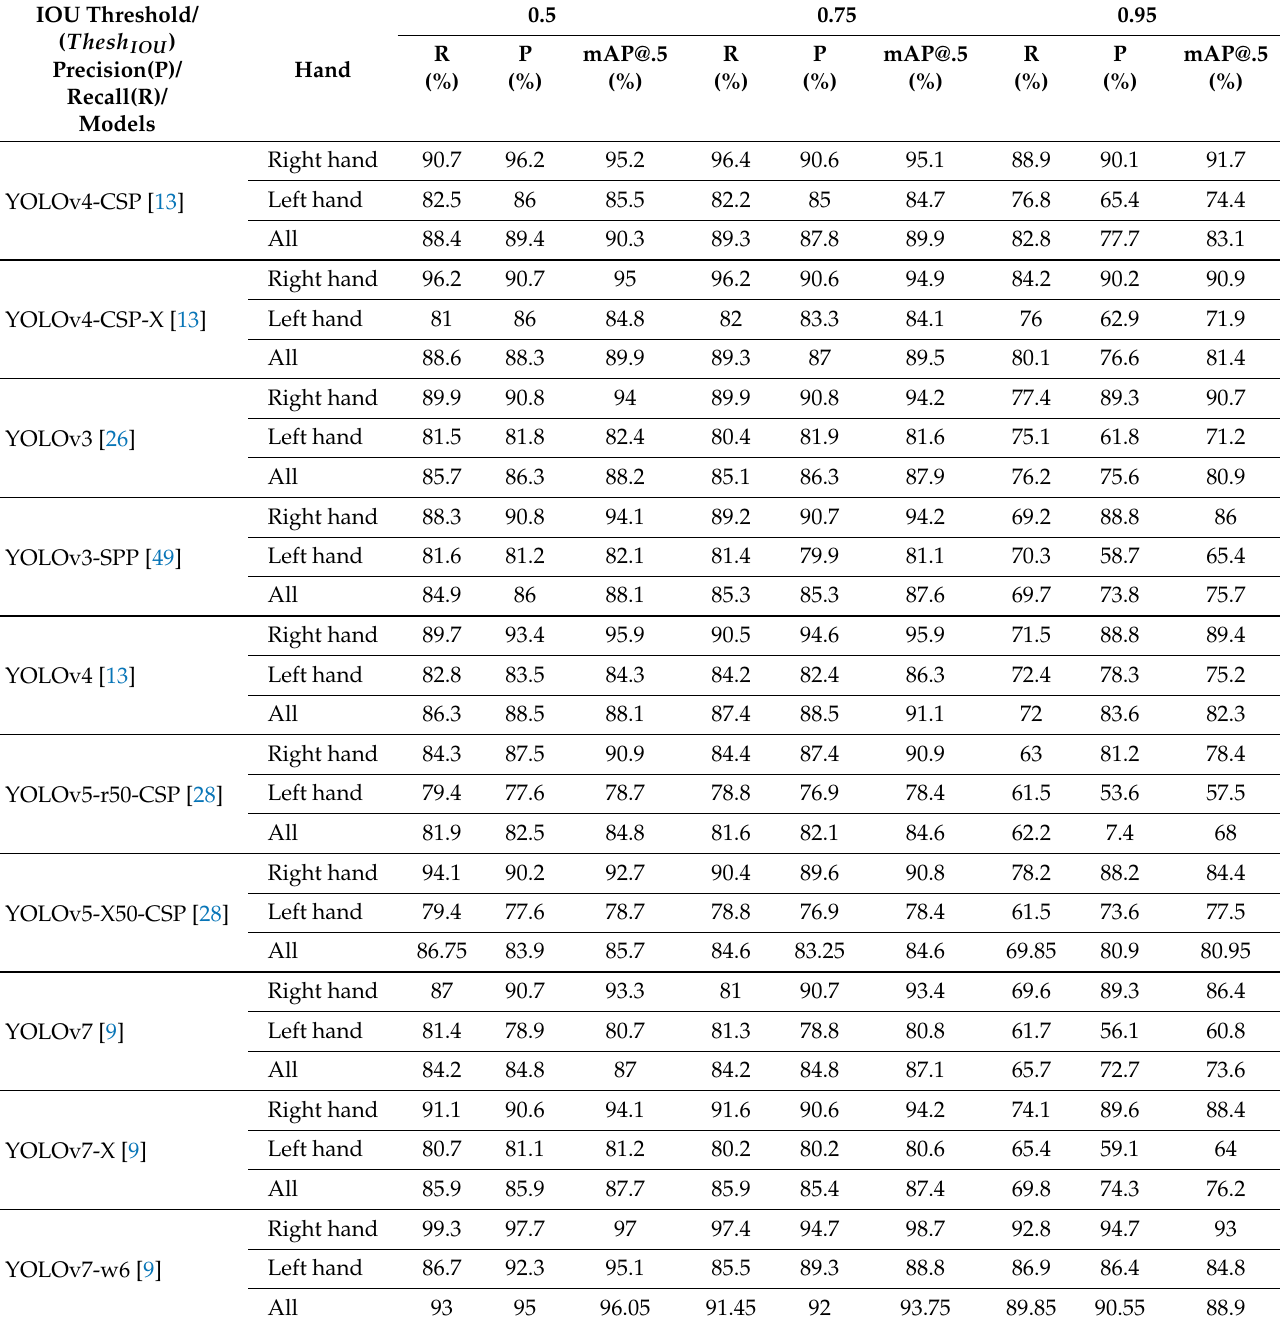
Table 3. The results of hand detection and classification on the HOI4D dataset